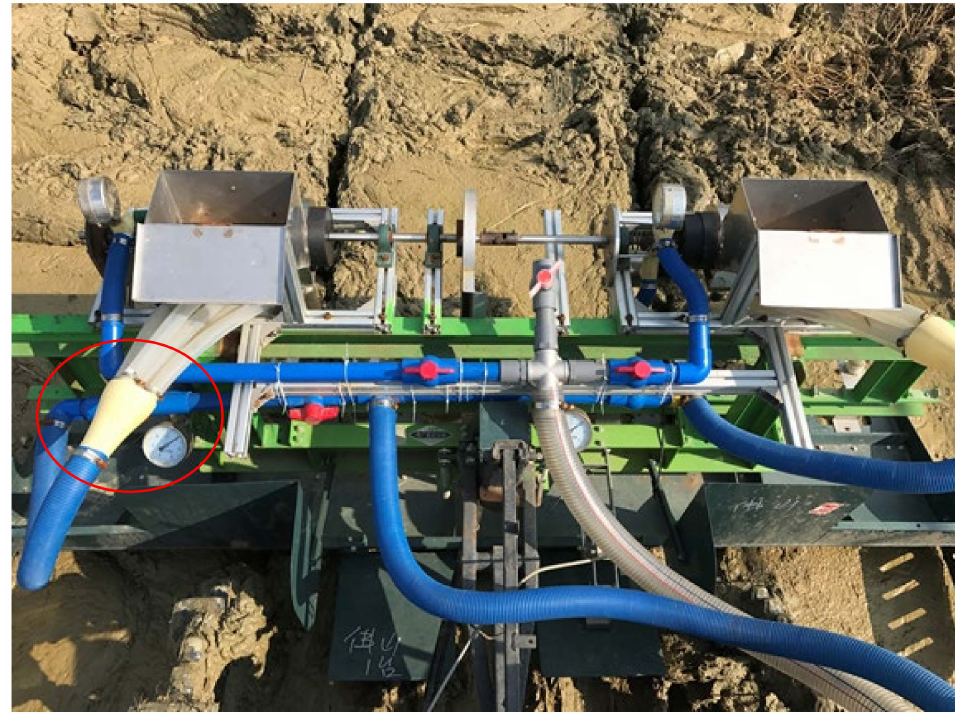
Figure 14. The installation drawing of type (C) arc transition air distributor. Table 6. The delivery airflow uniformity experiment of ten different delivery tubes. unit: m/s.